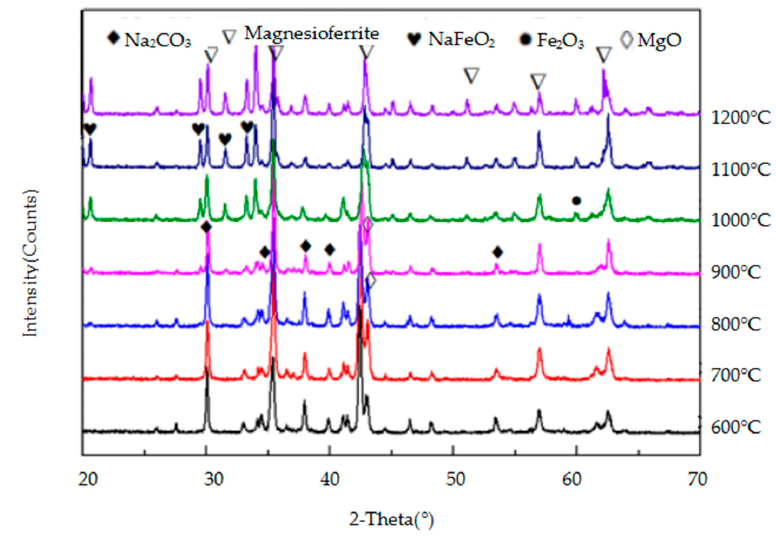
Figure 12. XRD patterns of the products of the reaction between MgO · Fe 2 O 3 and Na 2 CO 3 .